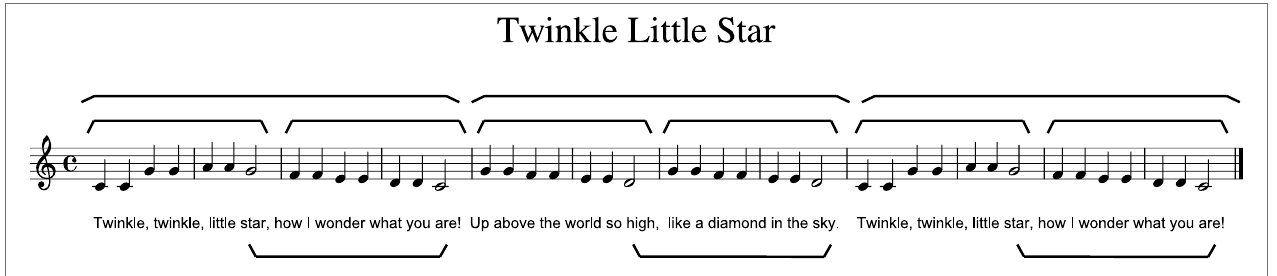
FIGURE 2 | A typical children’s song that follows the rules of the grammar. Above the notes, the phrases and subphrases are marked by brackets, and the ones below the text mark the rhymes. Note, for instance, the symmetrical organization and the salient boundaries of the phrases and